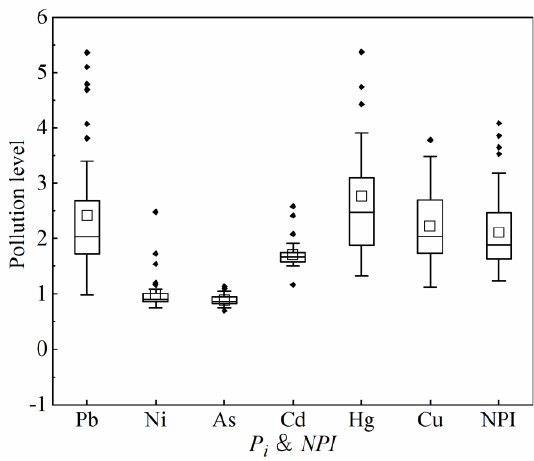
Figure 3. Box plots of pollution levels of heavy